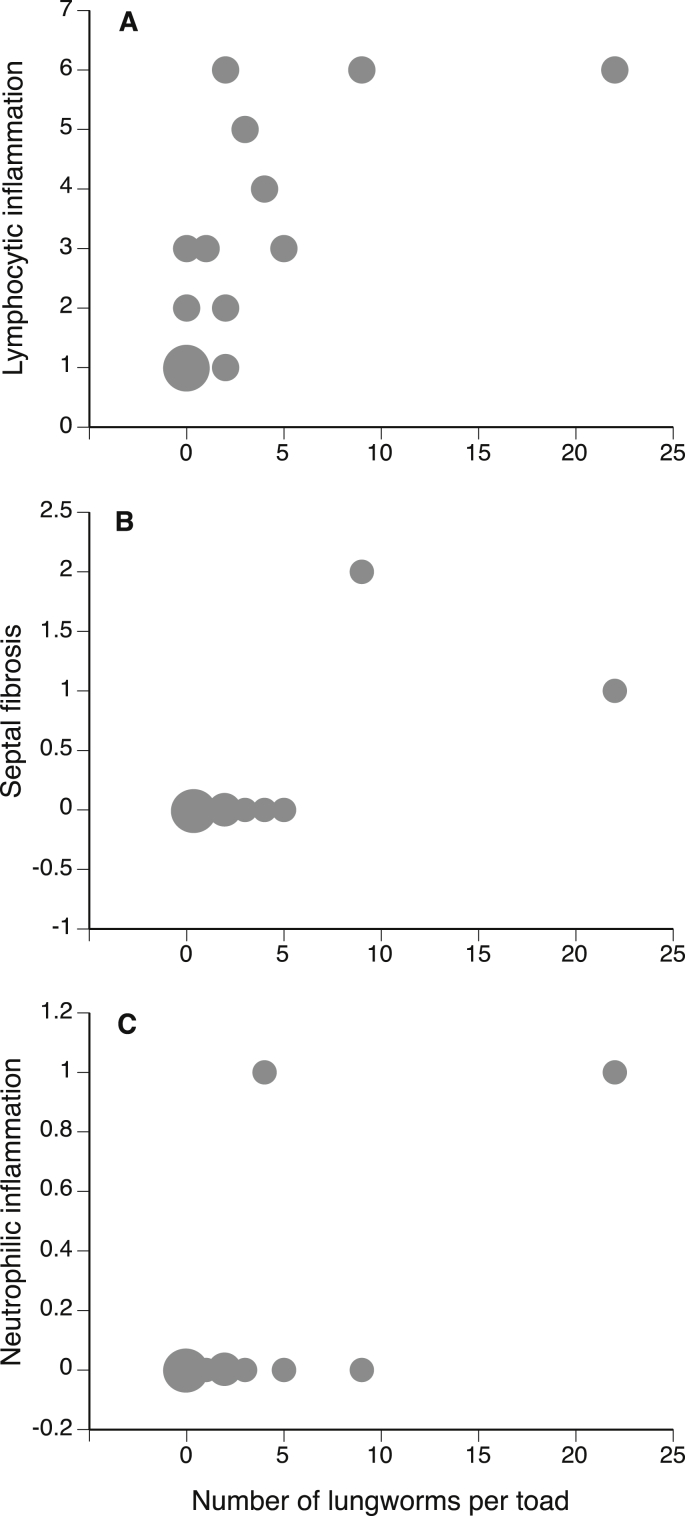
The effects of lungworm (Rhabdias pseudosphaerocephala infection level on lung pathology of 15 cane toads. (A) number of areas of inflammation predominated by lymphocytes, (B) number of areas of regional septal fibrosis, and (C) areas of inflammation predominated by neutrophils and macrophages. The size of the symbols represents sample size of each count.